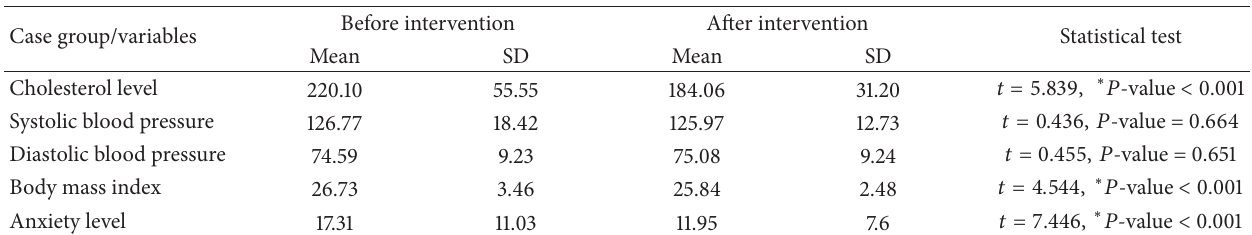
Table 4: Comparison of average and criterion deviation of anxiety level, body mass index, cholesterol level, and blood pressure in the patients with myocardial infarction before and after intervention in the case group in